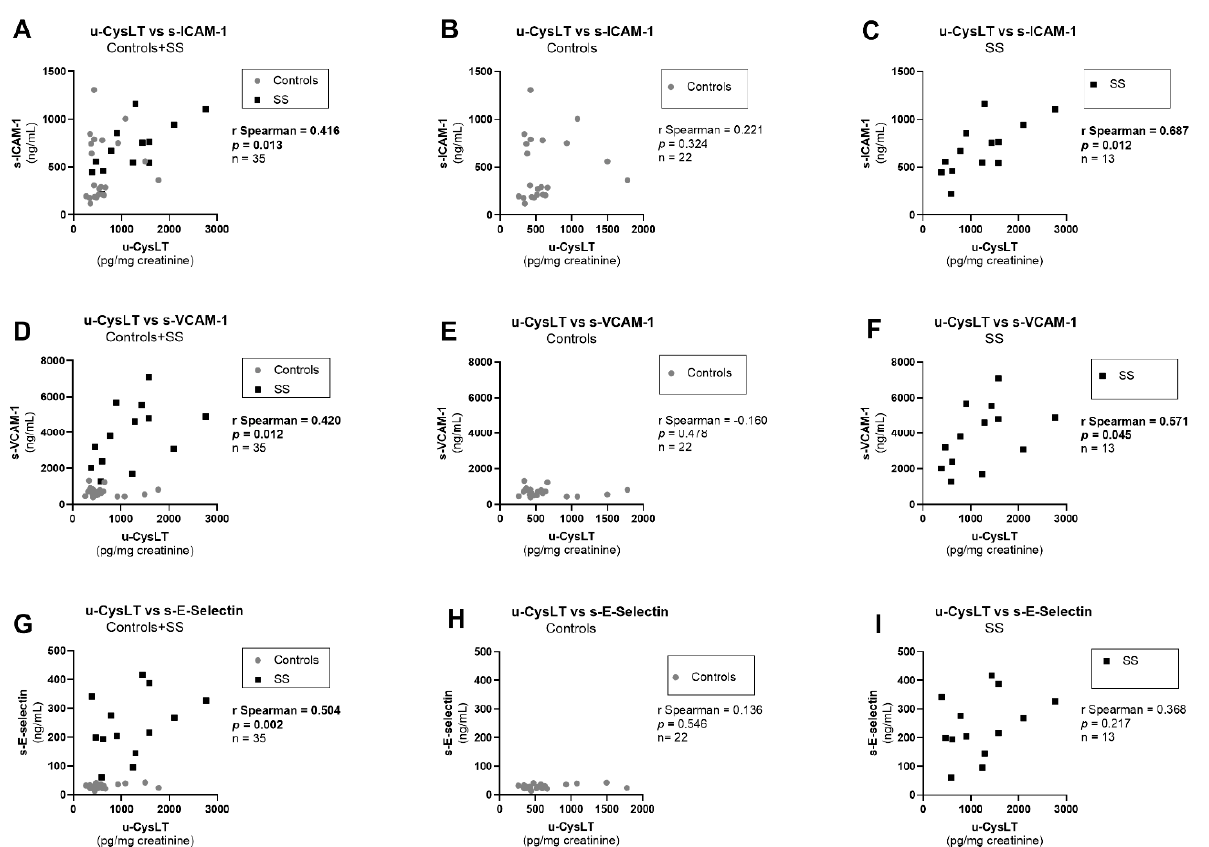
Figure 4. Correlations between u-CysLT and endothelial-activation biomarkers at admission in the overall study population and separately in controls and in SS: ( A ) u-CysLT vs. s-ICAM-1 in Controls + SS; ( B ) u-CysLT vs. s-ICAM-1 in Controls; ( C ) u-CysLT vs. s-ICAM-1 in SS; ( D ) u-CysLT vs. s-VCAM-1 in Controls + SS; ( E ) u-CysLT vs. s-VCAM-1 in Controls; ( F ) u-CysLT vs. s-VCAM-1 in SS; ( G ) u-CysLT vs. s-E-Selectin in Controls + SS; ( H ) u-CysLT vs. s-E-Selectin in Controls; ( I ) u-CysLT vs. s-E-Selectin in SS. s-ICAM-1, serum intercellular adhesion molecule 1; s-VCAM-1, serum vascu- lar adhesion molecule 1; s-E-Selectin, serum E-Selectin; u-CysLT, urinary cysteinyl leukotrienes. The values of u-CysLT were corrected for the respective urinary creatinine concentrations.